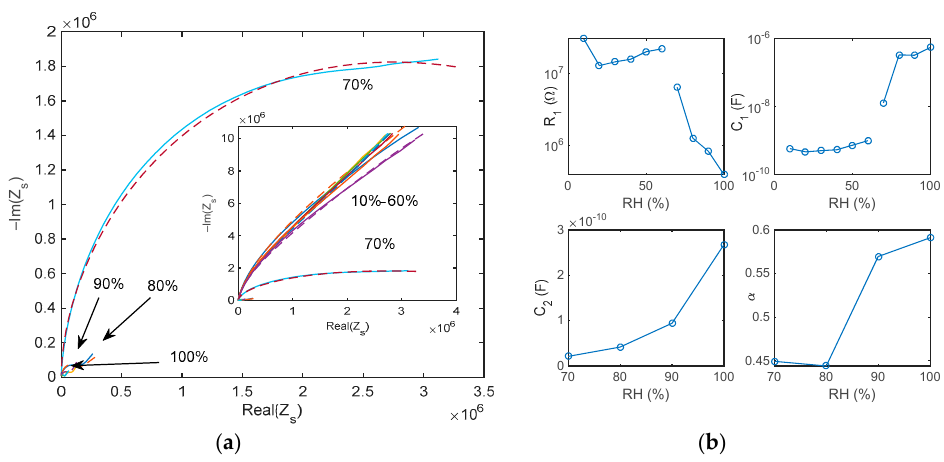
Figure 12. ( a ) Impedance Nyquist plot in the frequency range 50 Hz–80 kHz at different and constant RH levels for the TiO 2 Au2 sample; solid-colored lines: experimental data at different RH levels (as per legend); dashed red lines: equivalent model fitting results. ( b ) Estimated parameters of the fitted equivalent circuits: R 1 (upper left plot), C 1 (upper right plot), C 2 (lower left plot) and α (lower right plot).